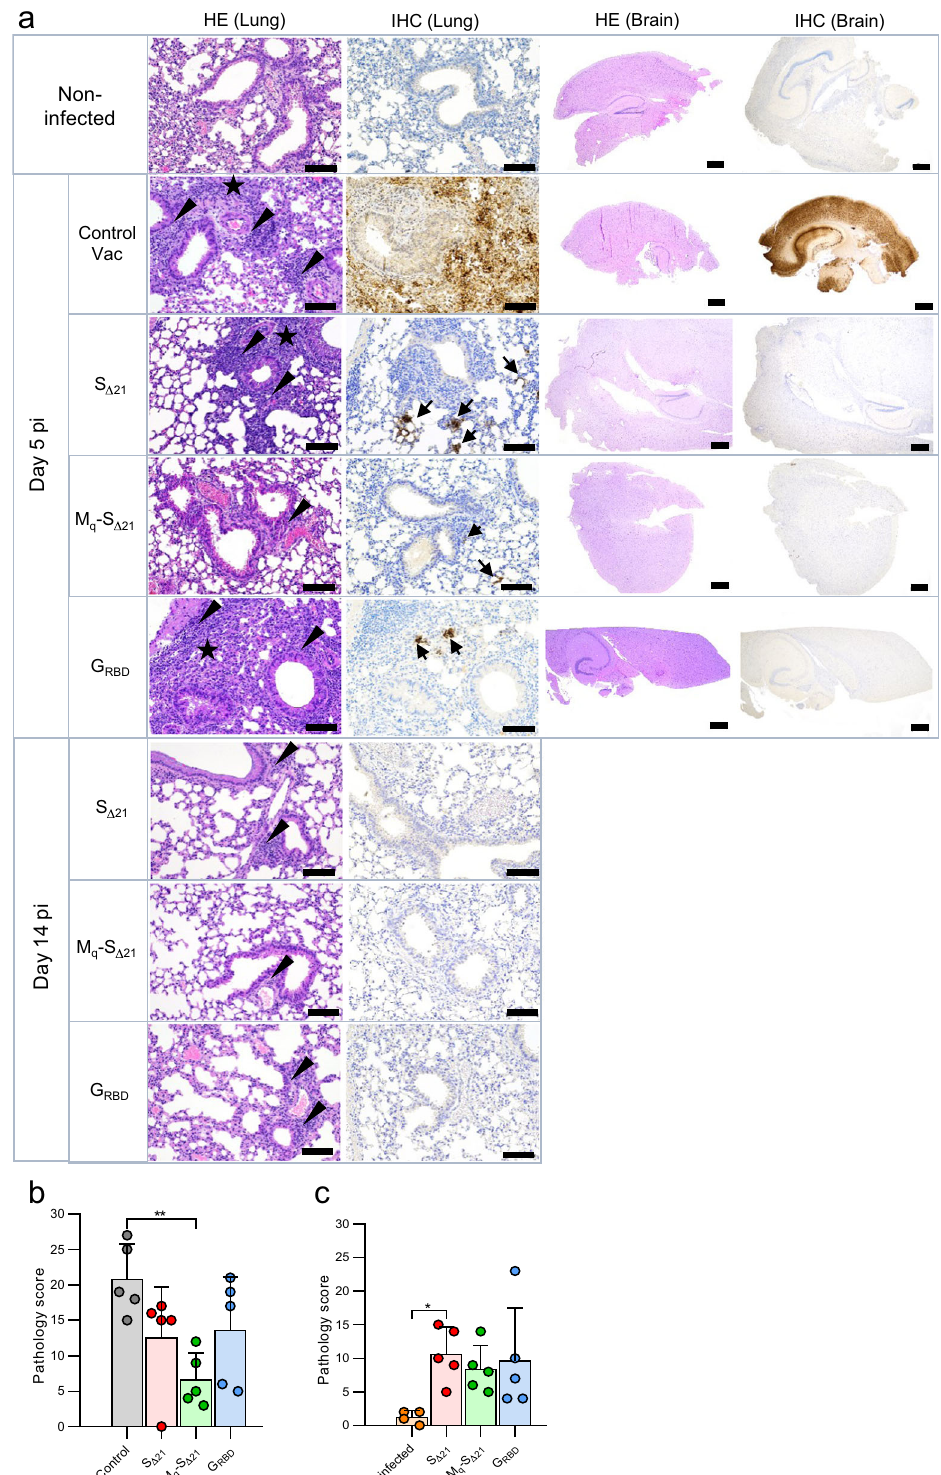
via the nasal route with 3 x 10 4 pfu of SARS-CoV-2-S D614G and euthanized on day 5 pi to determine virus and antibody titers. While offspring of naïve mice lost weight, 4 out of 5 offspring from vaccinated/infected mice gained weight (Fig. 5b). One offspring of the immune mothers lost weight and had high virus titers in brain